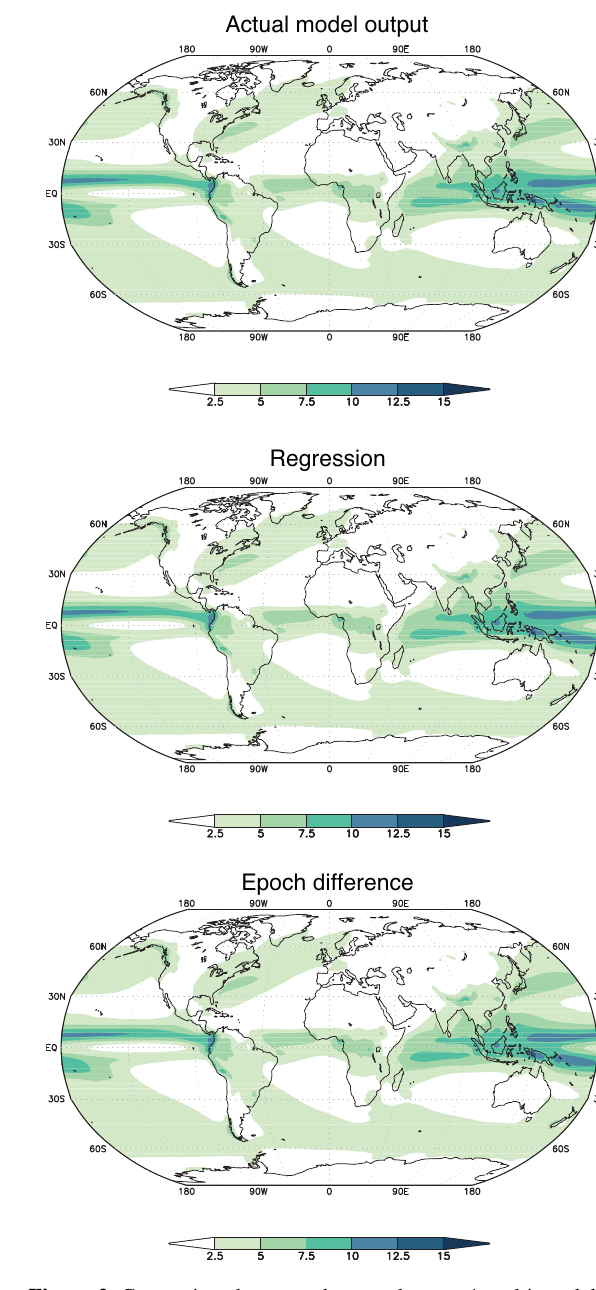
Figure 2. Comparison between the actual group 1 multi-model av- erage precipitation output (top) and the reconstructions produced by pattern scaling ( ˆ B in Eq. 1). All values are in mmday − 1 and represent averages over years 116–140 of the 1pctCO2 simulation. Middle panel shows the regression method, and bottom panel shows the epoch-difference